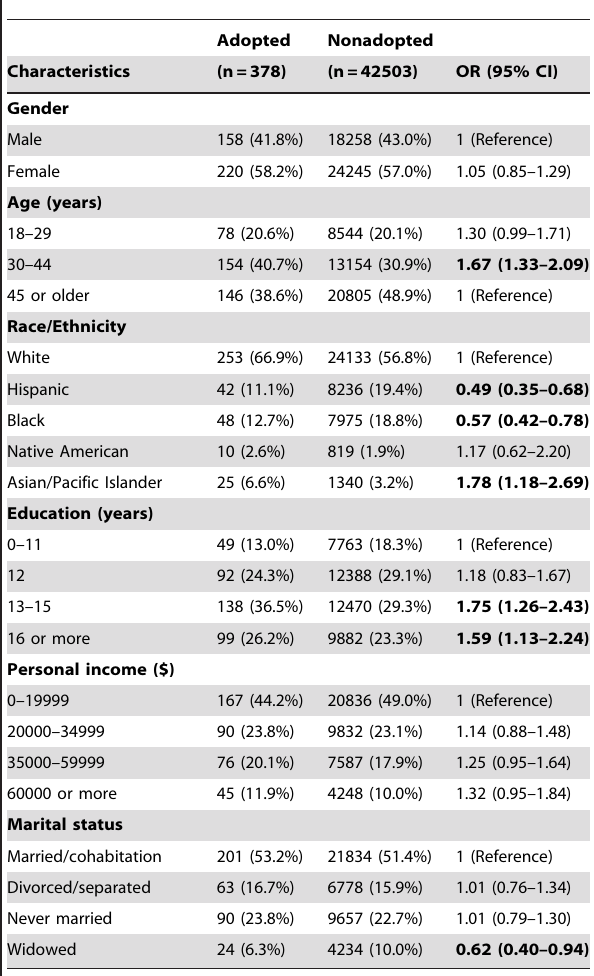
Table 1. Demographic characteristics of adopted and nonadopted